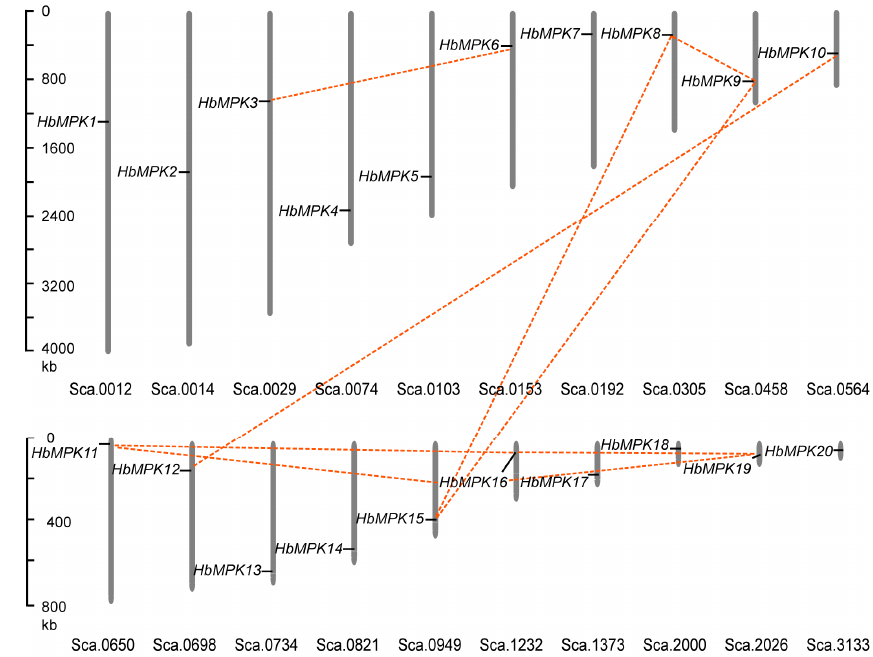
Figure 2. Scaffold distribution of MPK genes in Hevea . HbMPK family members were distributed onto 20 individual scaffolds. Scaffolds are represented by vertical columns, and scaffold numbers are shown at the bottom. Scale bars are on the left. Red lines connect paralogues.